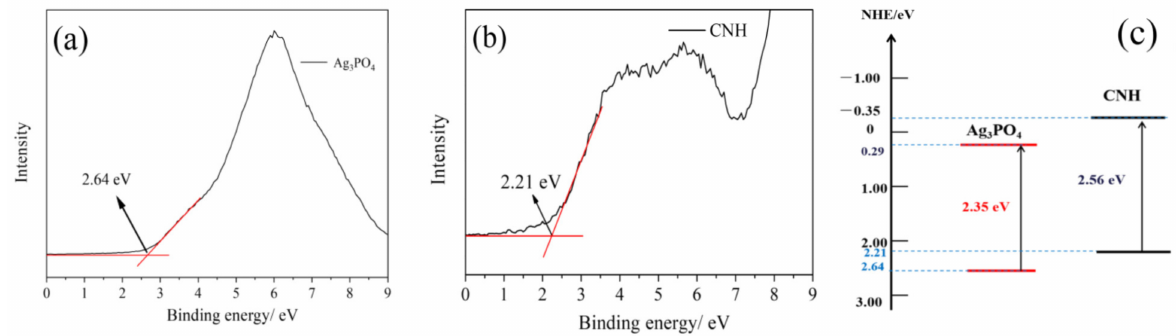
Figure 9. ( a , b ) VB-XPS spectra and ( c ) energy diagrams of Ag 3 PO 4 and